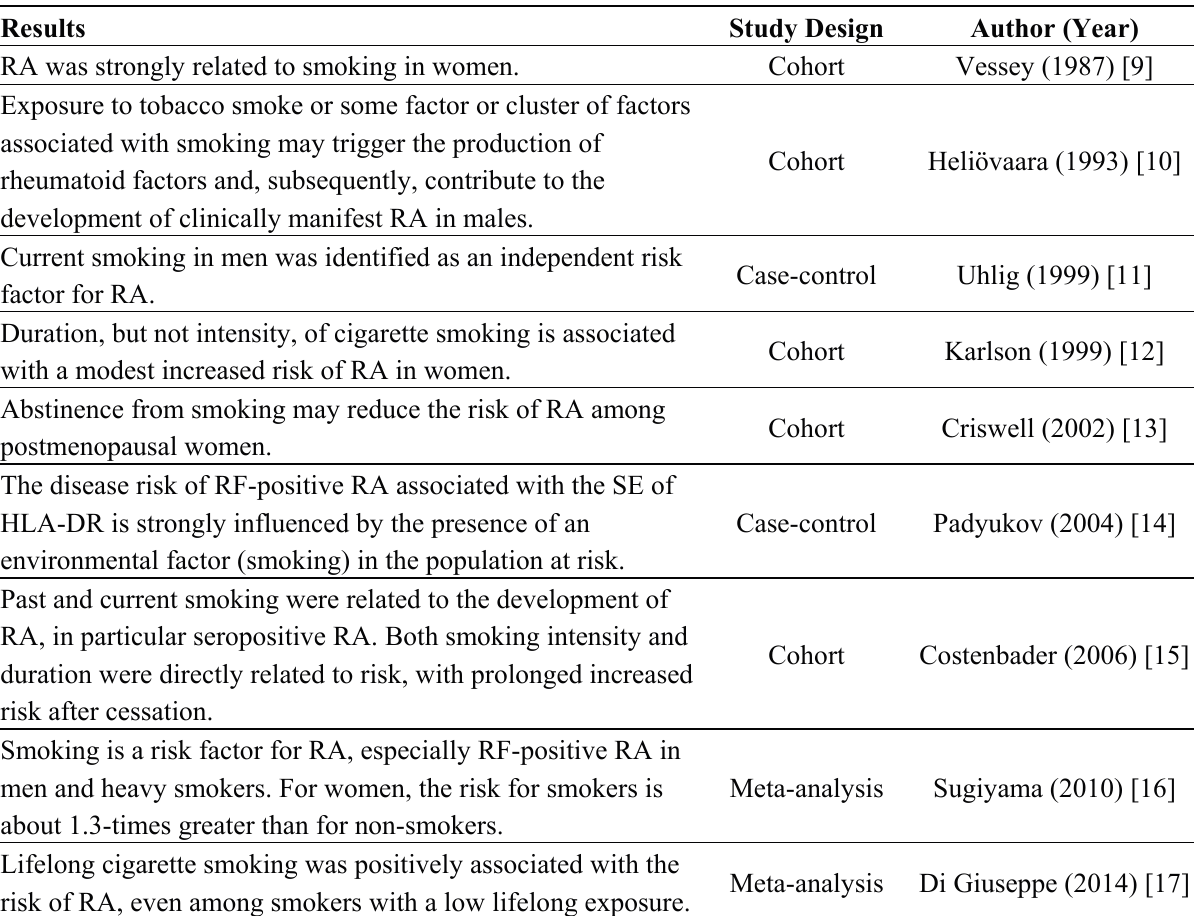
Table 1. Results of studies on smoking and rheumatoid arthritis (RA). SE, shared